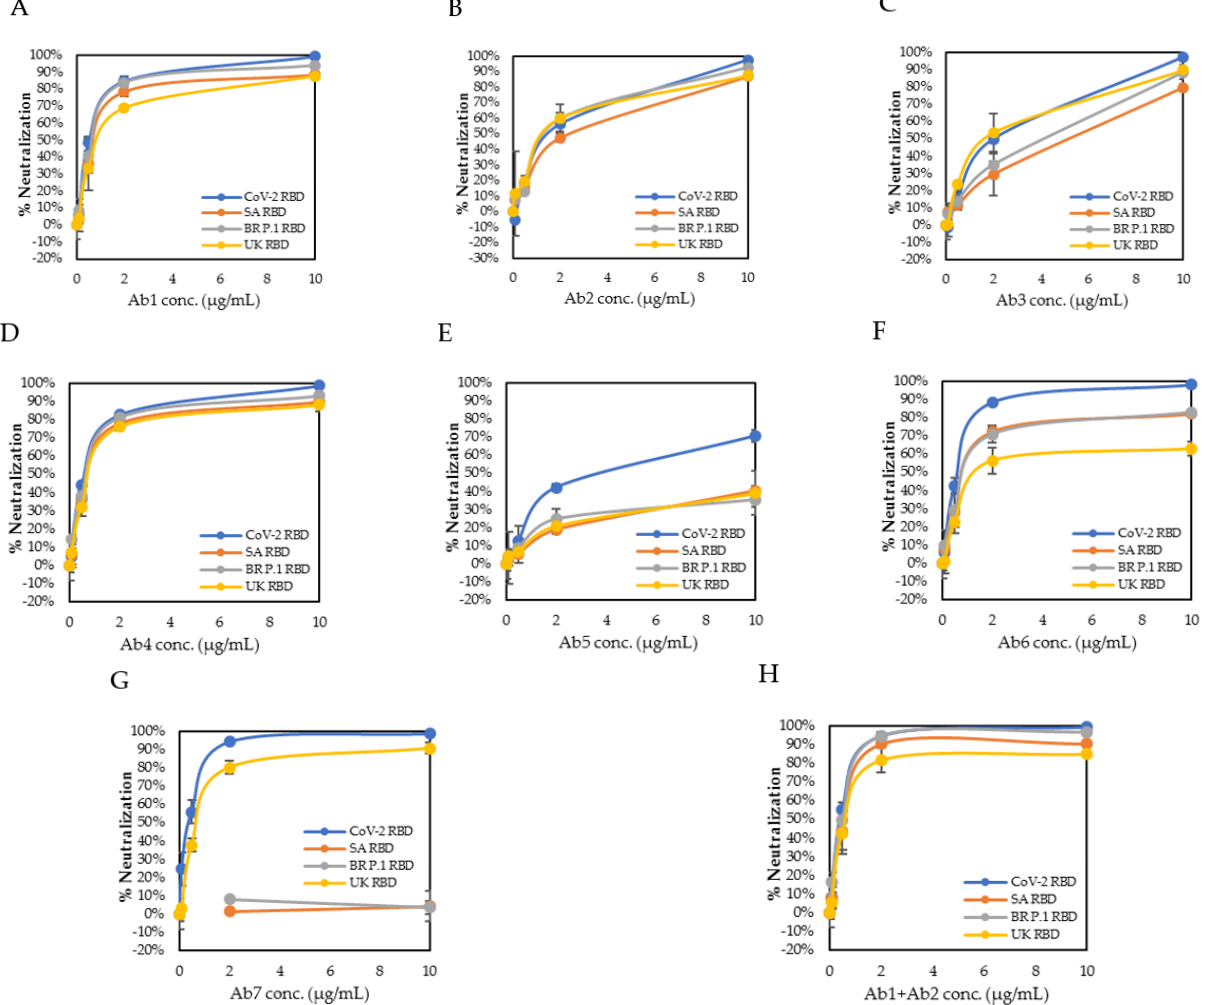
Figure 6. Neutralization kinetics by lateral flow cassette neutralization assays. ( A – G ) Kinetic curves for individual antibodies against the four RBDs. ( H ) Kinetic curve for the two combined antibodies against the four RBDs. Ab1 and Ab2 were used at the same concentration for each level.